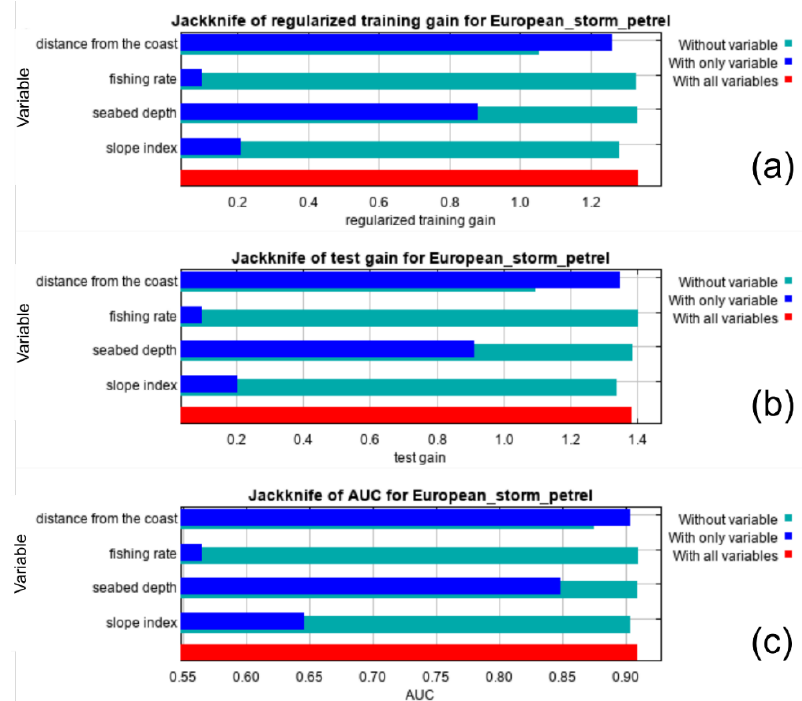
Figure 11. Results of the MaxEnt jackknife test of ( a ) regularized training gain, ( b ) test gain, and ( c ) AUC, for the European storm petrel. It shows the importance of each variable (distance from the coast, fishing rate, seabed depth, slope index) by excluding each variable (light blue), by considering only that variable (blue), and then by considering all the variables together (red).